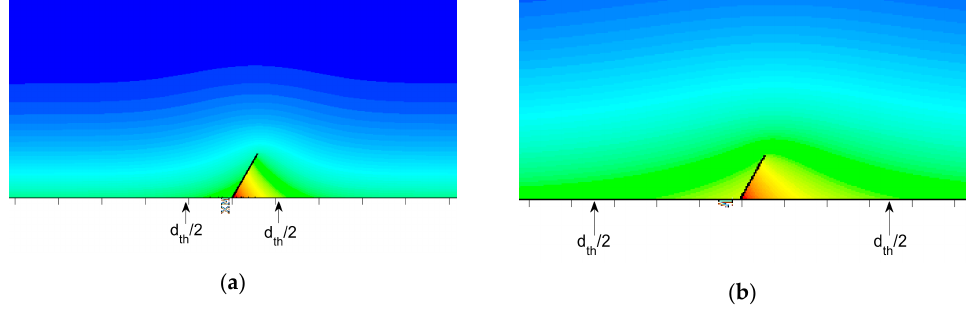
Figure 12. Temperature distribution after 0.1 s ( a ) and after 1 s ( b ) heating pulses, simulated for the same crack as in Figure 11b. In the figures, d th /2 is also marked, which is approximately the distance where the phase is at its minimum.